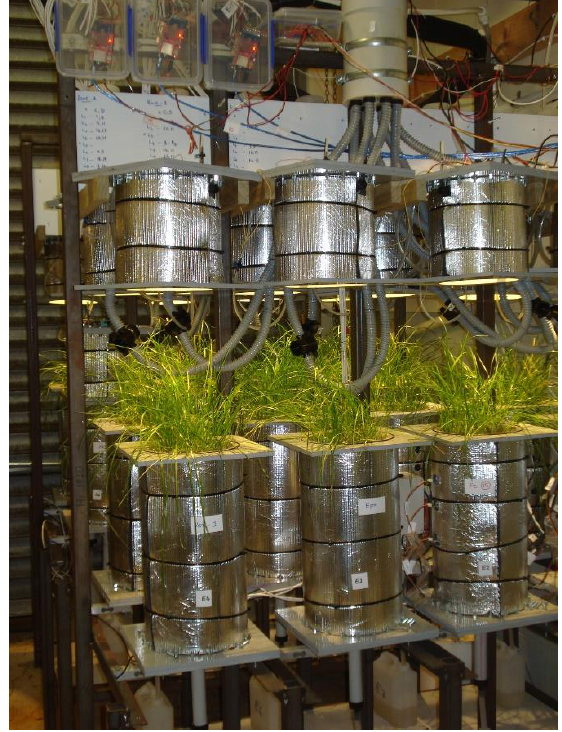
Figure 8. Image of the specially designed lysimeter with a cap for the climate-controlled study (This image was taken before grass clipping and caps were removed from the lysimeter body to perform grass clipping).